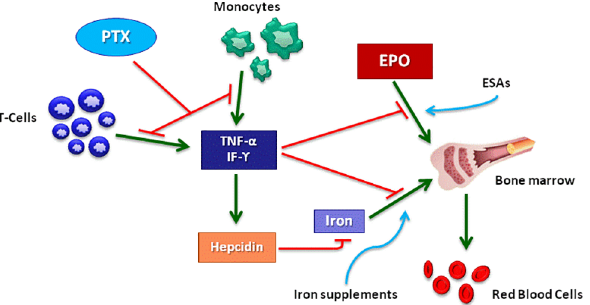
Fig 8. Inflammation plays a key-role in the genesis of anemia in CKD. TNF- α and IF- U are pro-inflammatory cytokines which may generate or worsen anemia by limiting the pro-erythropoietic effect of EPO and ESAs at the medullary level. In addition, such cytokines may reduce iron bio-availability by increasing serum hepcidin levels. Pentoxifylline would improve anemia in CKD by inhibiting the release of TNF- α and IF- U from monocytes and T-cells. This would ameliorate the medullary sensitivity to endogenous EPO and exogenous ESAs and reduce the need for iron supplements by increasing endogenous iron availability. Legend to Fig 8: PTX: pentoxifylline, TNF- α : tumor necrosis factor alpha, EPO: erythropoietin, ESAs: erythropoiesis stimulating agents, IF- U : interferon